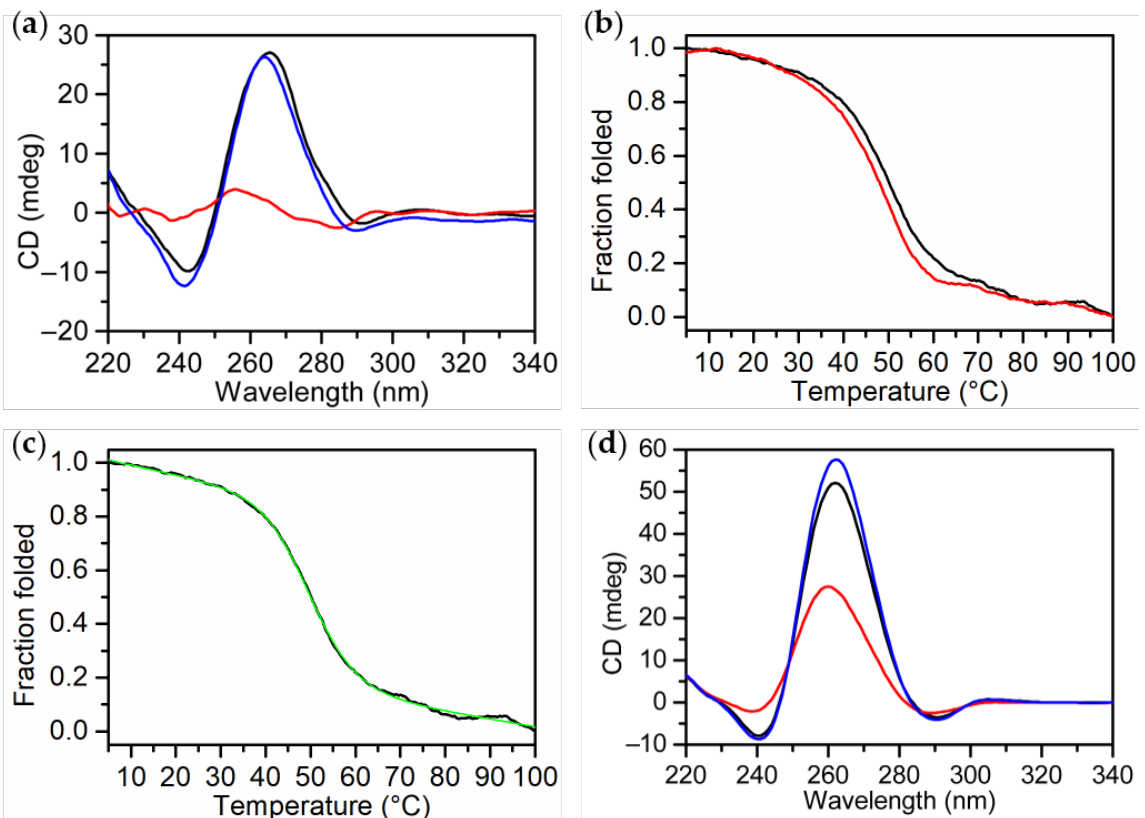
Figure 1. CD analysis of MS3 at 2 µM in the Na + -containing buffer (10 mM NaH 2 PO 4 /Na 2 HPO 4 , 90 mM NaCl solution, pH 7.0): ( a ) CD spectra of MS3 at 5 °C before (black line), after melting/cooling (blue line) and at 100 °C (red line); ( b ) CD melting (black line) and cooling (red line) profiles of MS3 recorded at 0.5 °C min −1 ; ( c ) CD melting curve (black line) and calculated Van ’t Hoff curve (green line). ( d ) CD spectra of MS3—recorded at 2 µM in PBS buffer (137 mM NaCl, 2.7 mM KCl, 10 mM NaH 2 PO 4 /Na 2 HPO 4 , 1.8 mM KH 2 PO 4 /K 2 HPO 4 , pH 7.3)—at 5 °C before (black line), after melt- ing/cooling (blue line), and at 100 °C (red line).